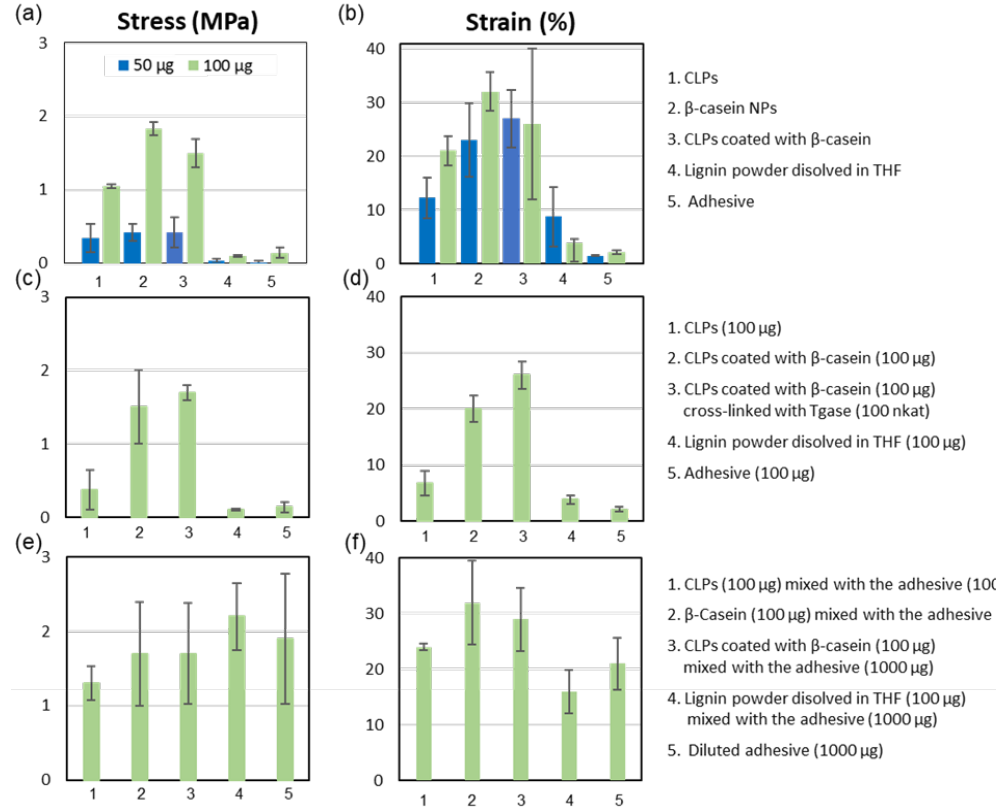
Figure 7. Comparison between tensile stress–strain histograms. ( a , b ) Different CLPs including the references at two quantities. ( c , d ) Effect of Tgase catalyzed cross-linking on the adhesion. ( e , f ) Various NPs including the references dispersed in diluted water-soluble adhesive.